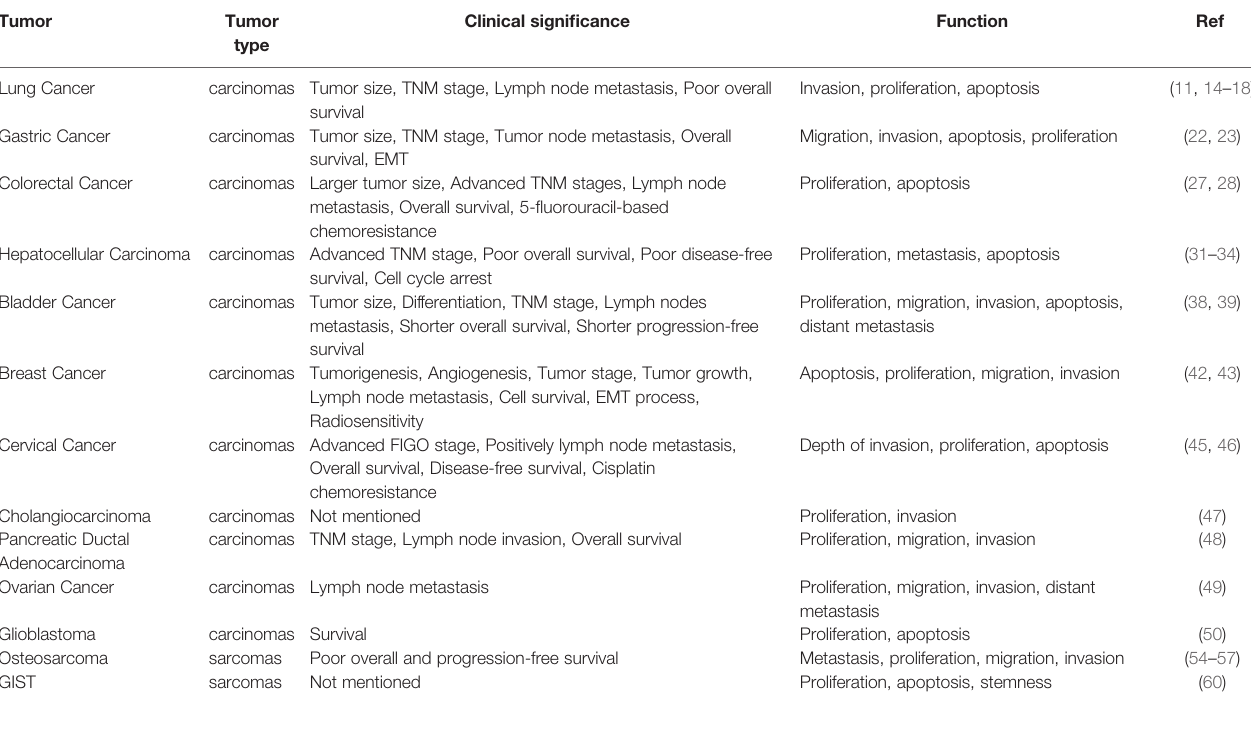
TABLE 2 | LncRNA PCAT6 with tumor type, clinical signi fi cance and functions in cancers. Tumor